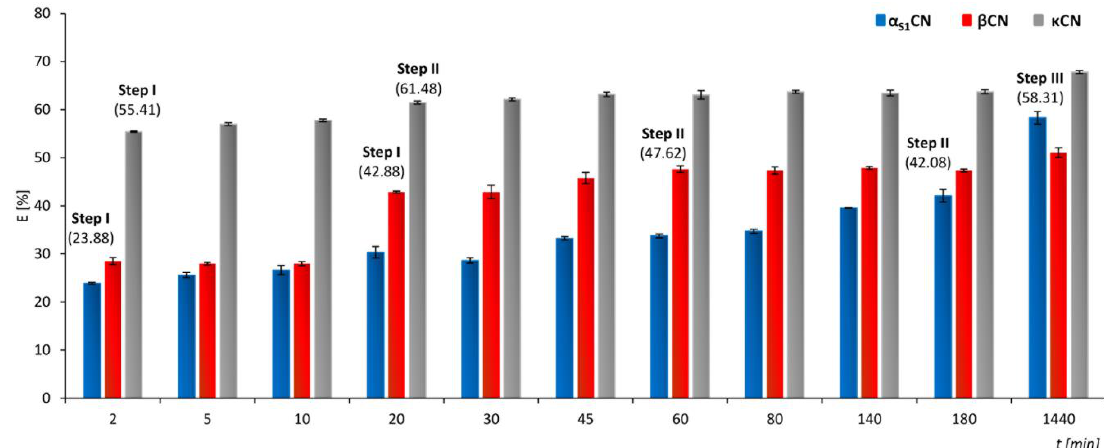
+ by α β CN and κ S1 CN,